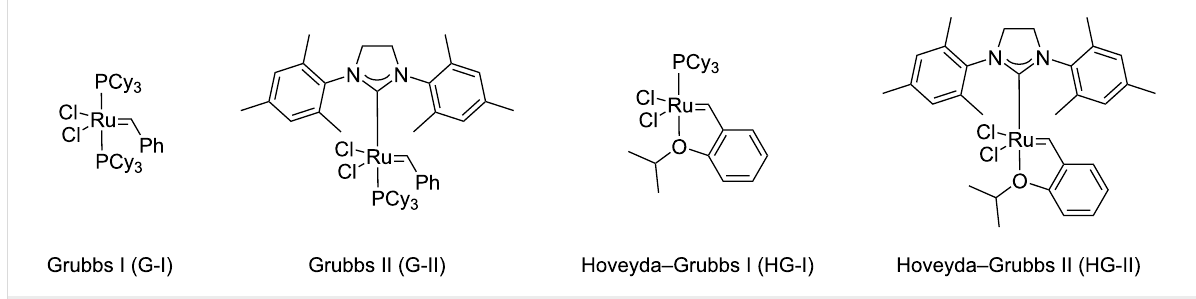
Figure 2: Commercially available first and second generation Grubbs and Hoveyda–Grubbs catalysts.